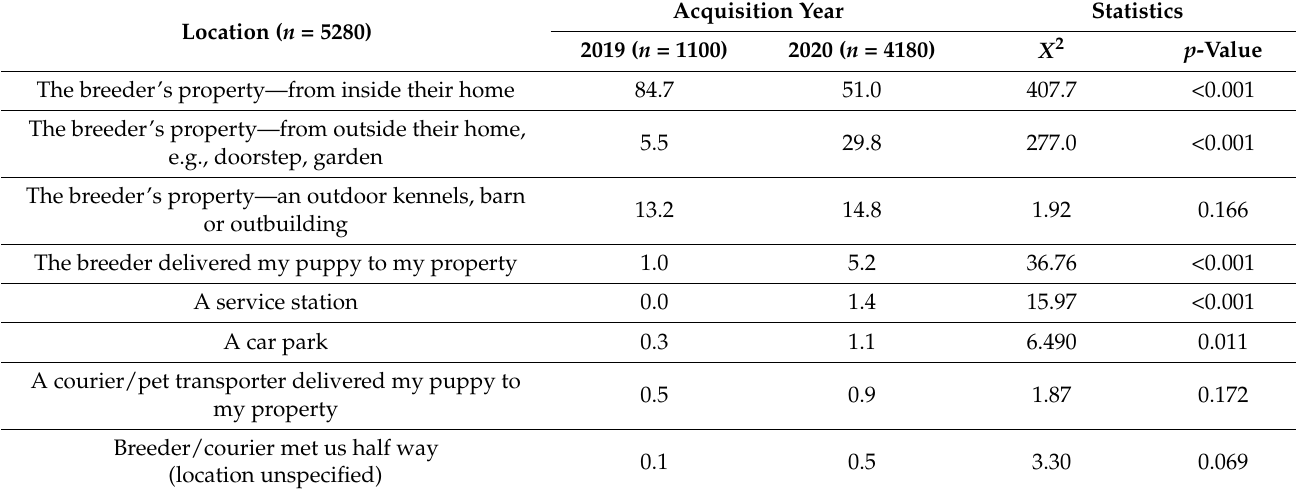
Table 11. Locations owners received their puppy with comparison between 2019 puppy owners ( n = 1100) and Pandemic Puppy owners ( n = 4180) in the